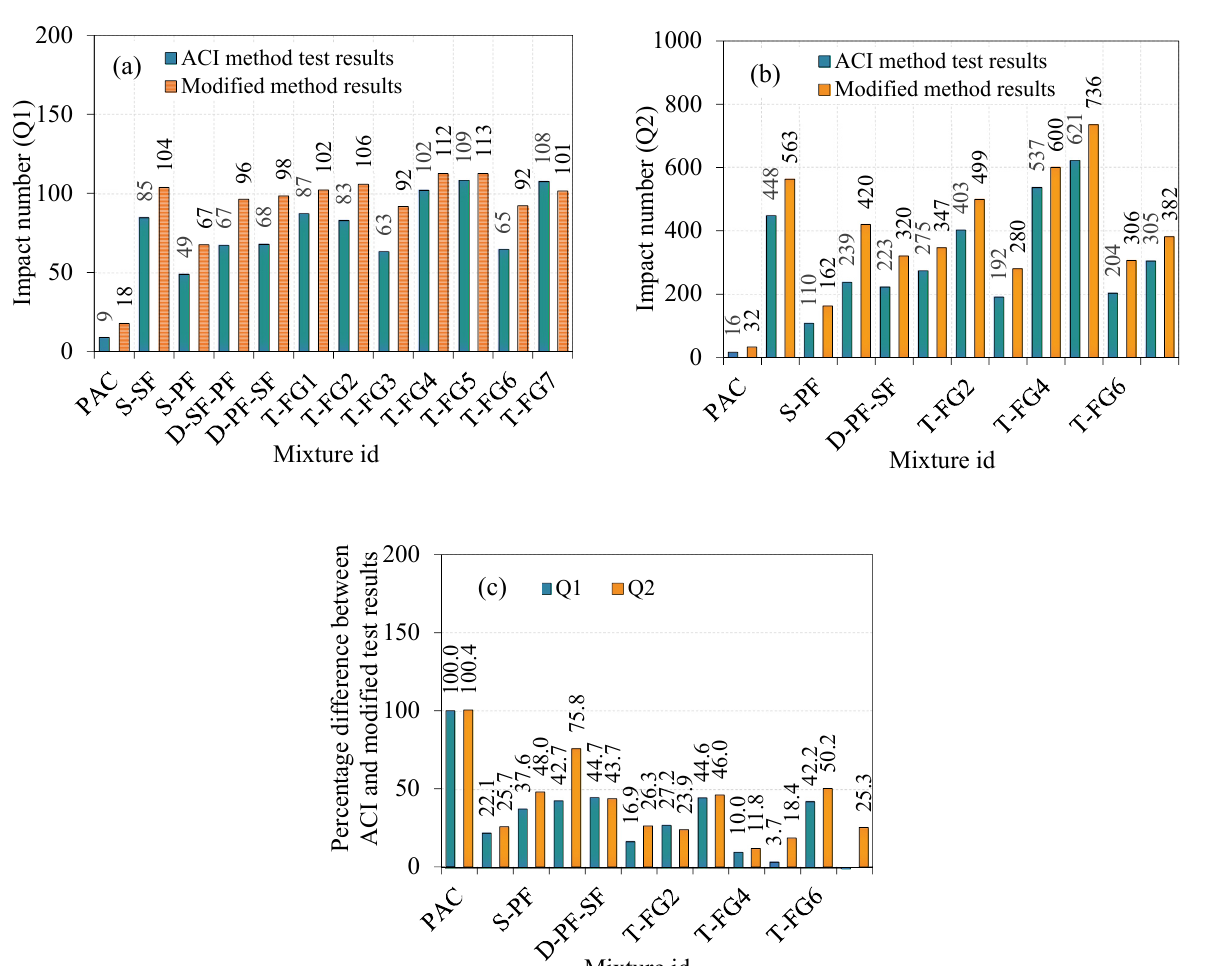
Figure 15. Comparison of the ACI and modified-method impact results ( a ) Q1 ( b ) Q2 ( c ) Percentage difference in Q1 and Q2.